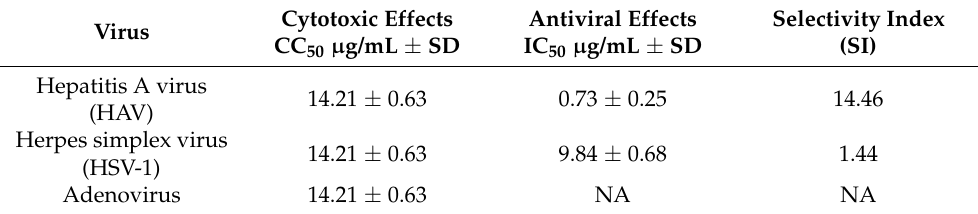
Table 4. The antiviral efficiency of clove essential oil against the tested